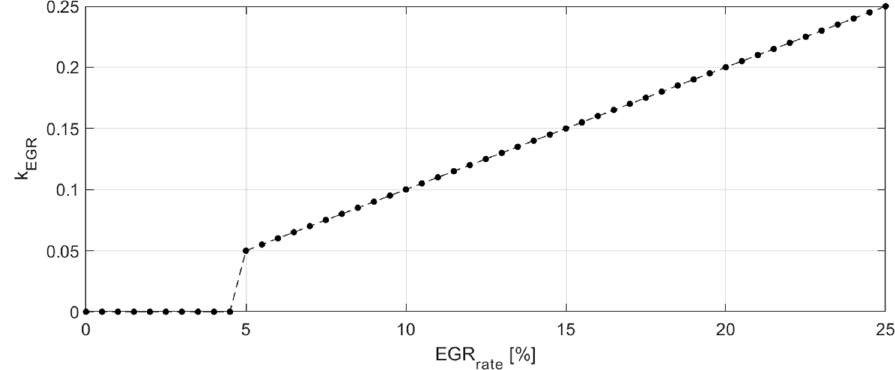
Figure 18. Calibration of 𝑘 𝐸𝑅𝐺 as a function of the EGR rate.